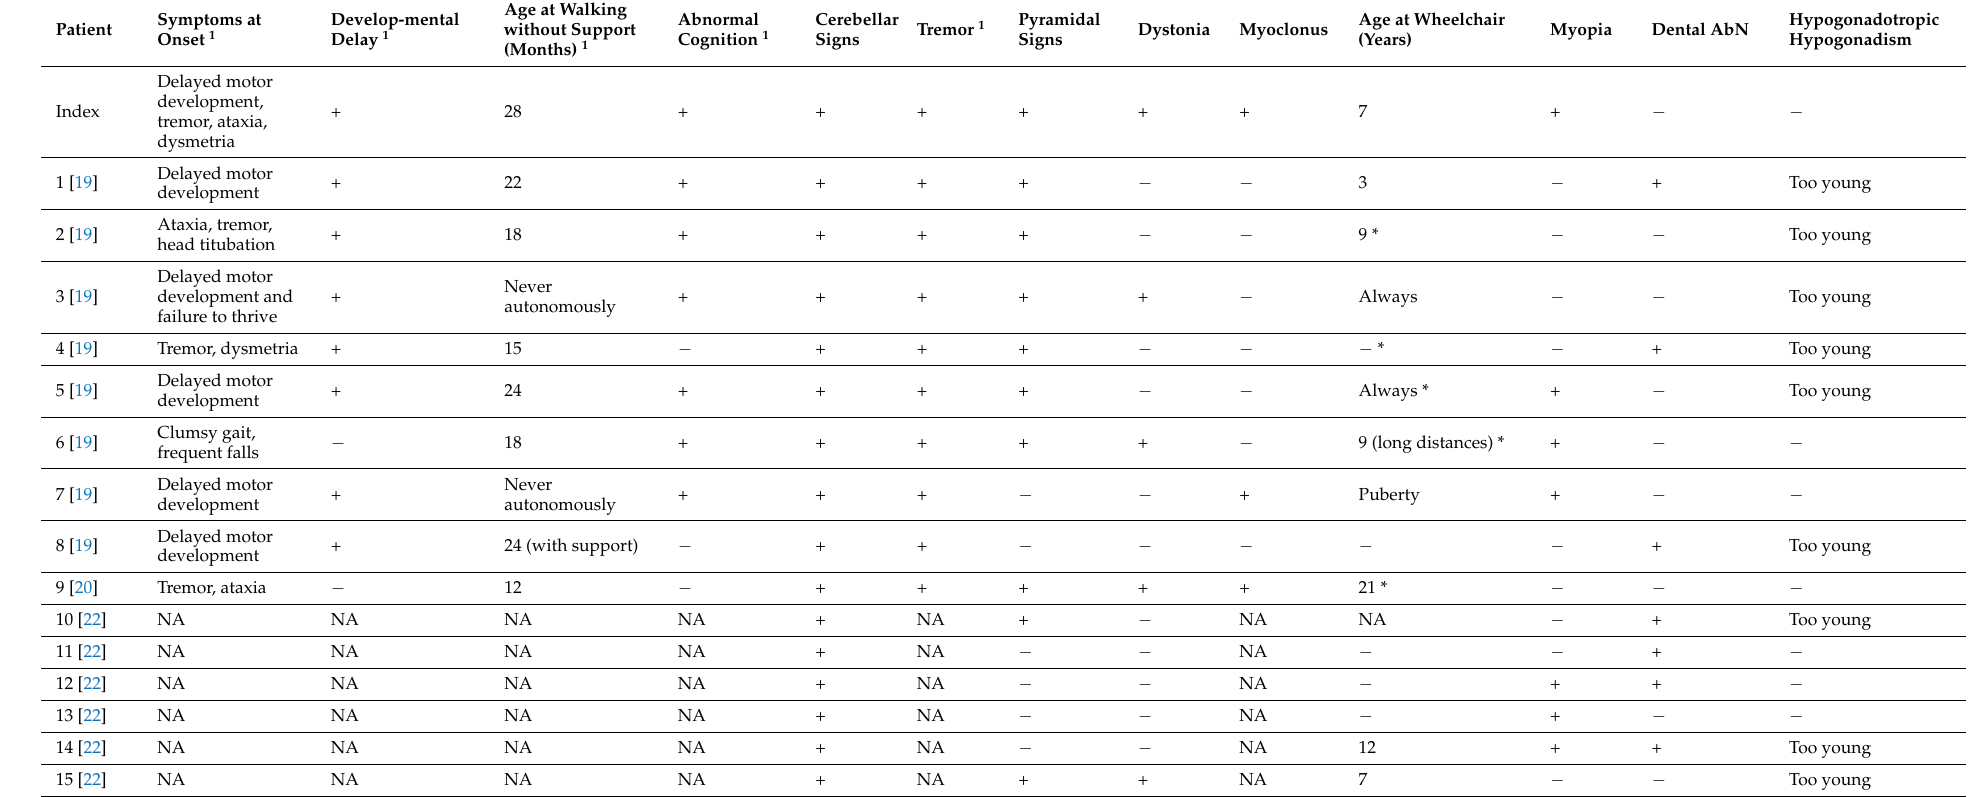
Table 2. Clinical characteristics of our patient and reported patients with POLR1C